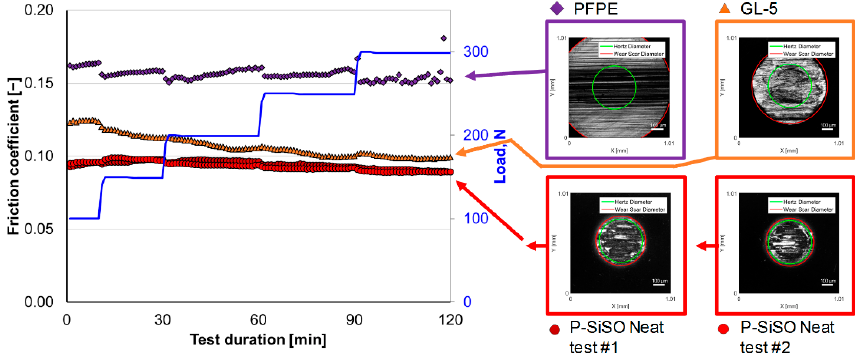
Figure 2. Results from tribotests at conditions V{100–300 N/25 °C/120 min}. The friction traces are shown for two repeated tests with neat P-SiSO, compared to one test with PFPE and one test of GL-5. The wear scars corresponding to the friction traces are shown as color-coded insets in the right part of the figure.